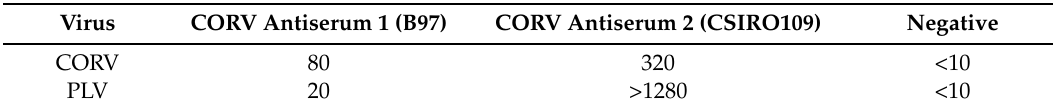
Table 4. Cross-neutralization of PLV with CORV